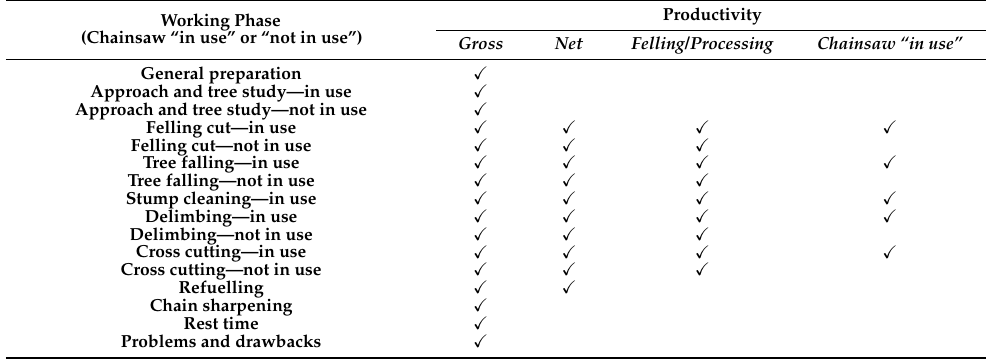
Table 2. Details of the working phases and the productivity type, showing where each working phase is included or